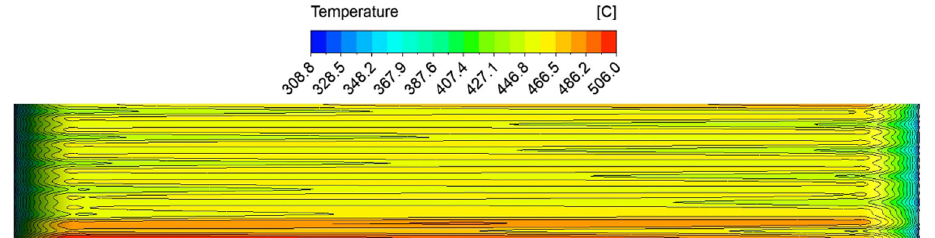
Figure 9. Temperature field at the tungsten external armor. The hot spot is placed in the bottom region, before the elbow.